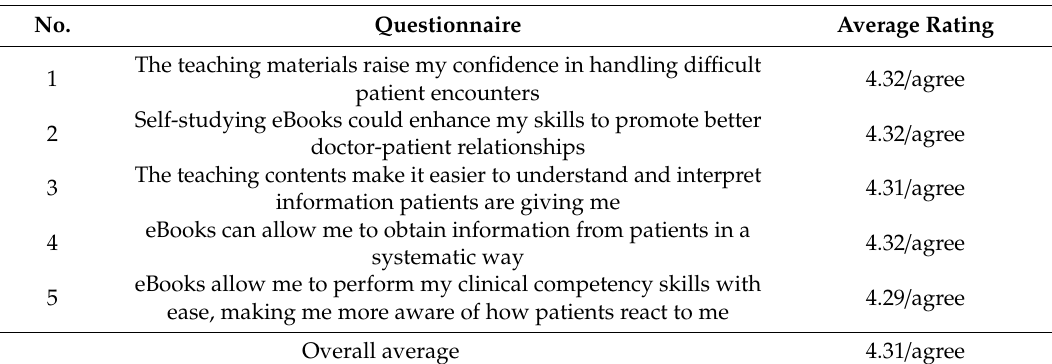
Table 3. Students’ responses in raising confidence during clinical practice and in developing good doctor-patient relationships. ( n = 50).